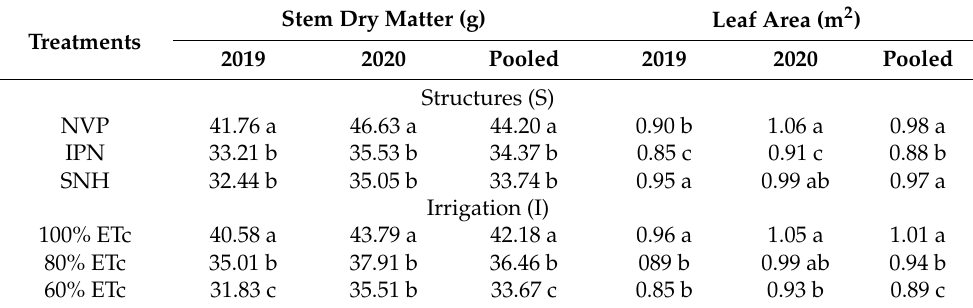
Table 3. Effect of protected structures and irrigation levels on canopy traits of tomato (plant − 1 ).